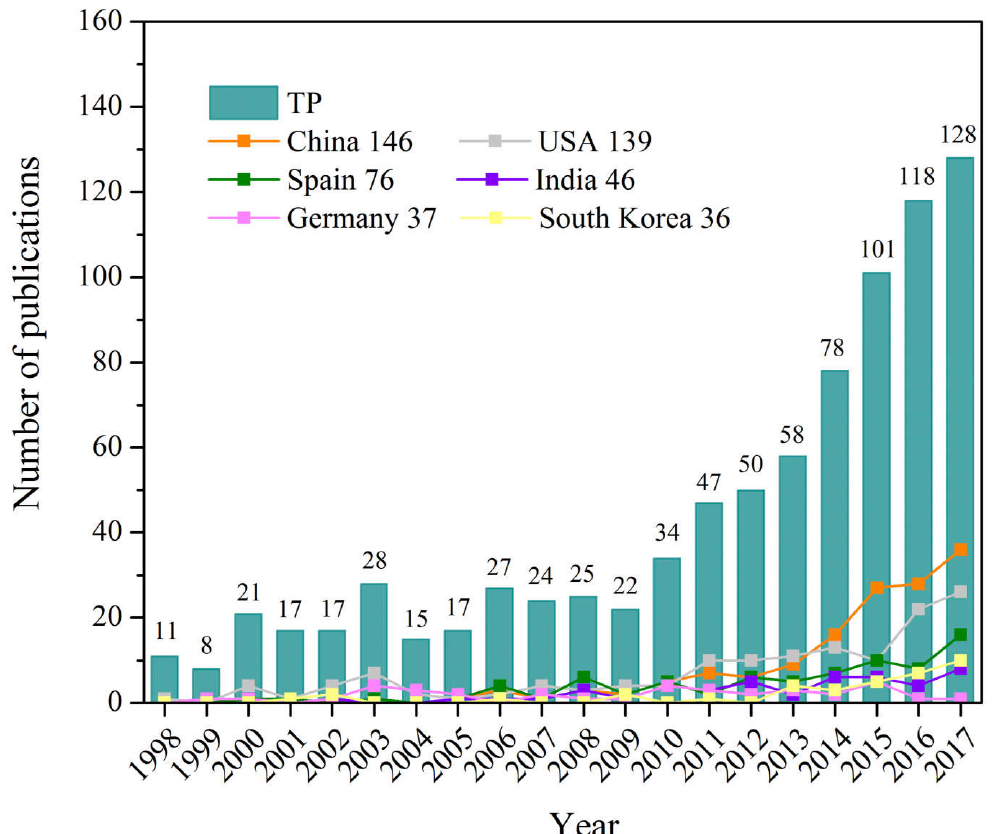
Figure 1. The annual publication number of top 6 productive countries during 1998–2017. TP, the total number of publications. The number after the country is the total number of its publications in this field over the time